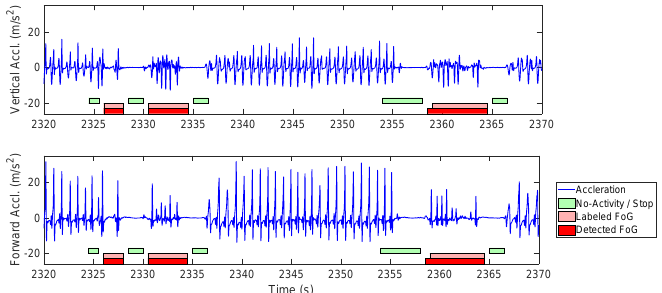
Figure 5. Acceleration signal collected from the right ankle sensor and the corresponding labeled and detected events using of ClsfBagging with β = 0.2 and C FoG = 2.